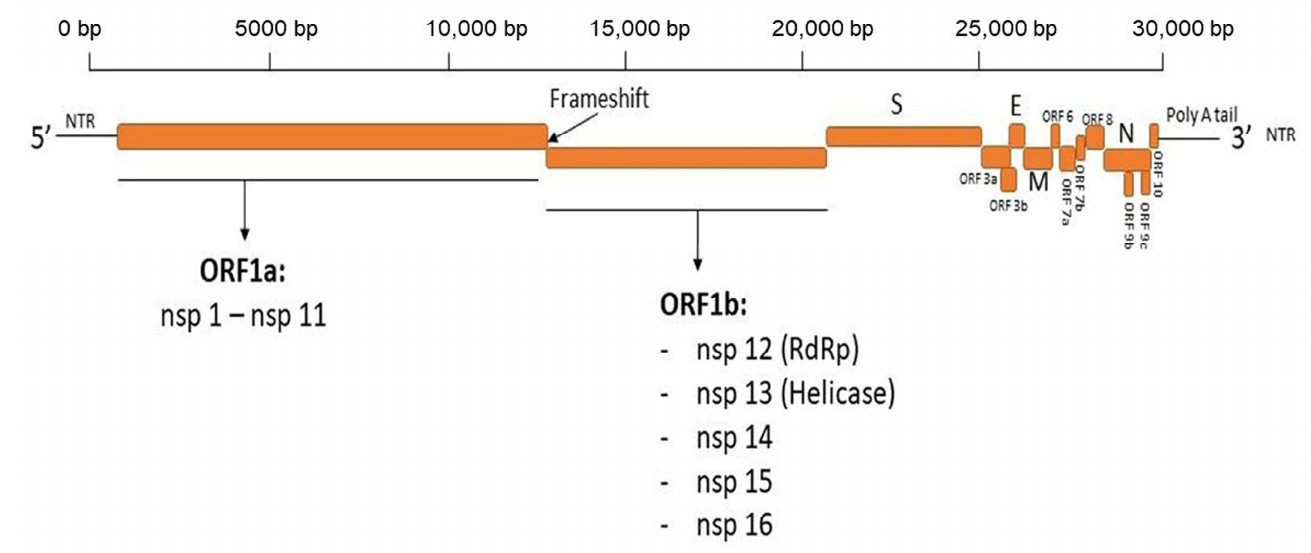
Figure 1. Diagram depicting the genome organization of SARS-CoV-2. The genome of SARS-CoV-2, with a size of ~30 Kb, encodes 4 structural proteins, 16 non-structural proteins (nsps), and 6 accessory proteins. The structural proteins, including spike glycoprotein (S), nucleocapsid (N), membrane (M), and envelope (E) proteins, are important for virus assembly and infection and are the target for the development of vaccines and therapeutics for COVID-19.